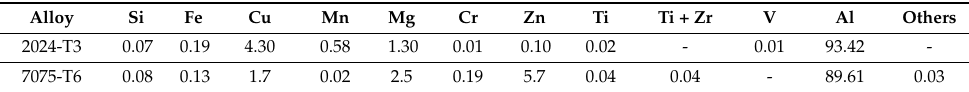
Table 1. Chemical composition (wt. %) of aluminum alloys 2024-T3 and